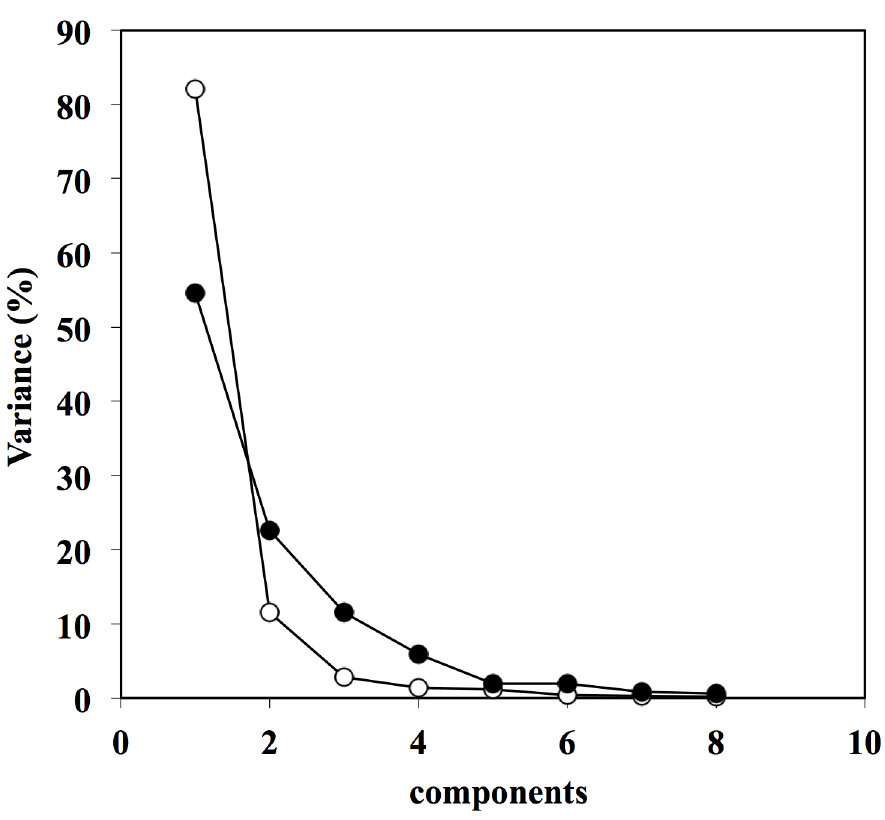
Fig 2. Principal component analysis (PCA). The graph represents the number of PCA components considered and the related percentage of variance. Notice the first component explains 85% of the variance for expert observers (EO) but only 56% of the variance for non expert observers